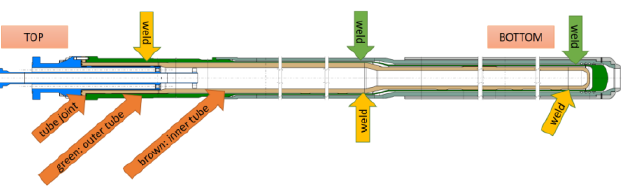
Fig. 1. ADELINE irradiation test device